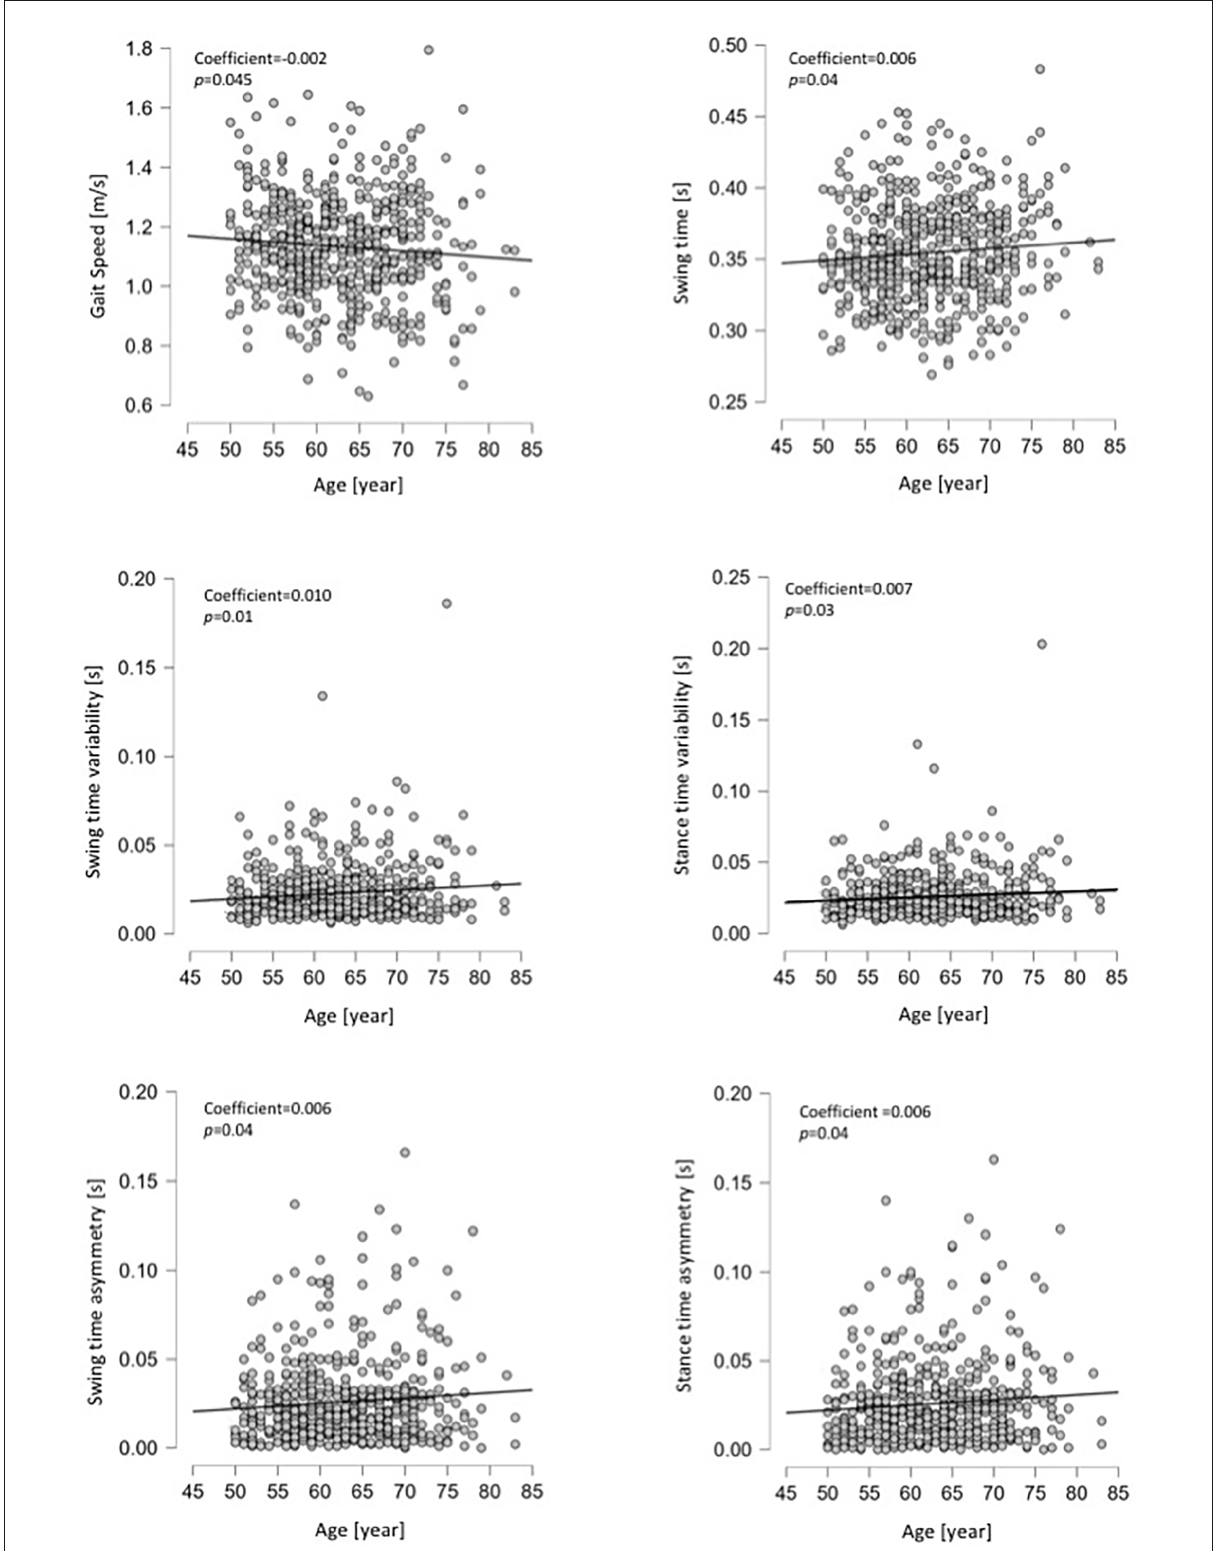
FIGURE1 Scatter plot with a fitted line of the linear regression in six gait parameters (in women) were age has significant predictive